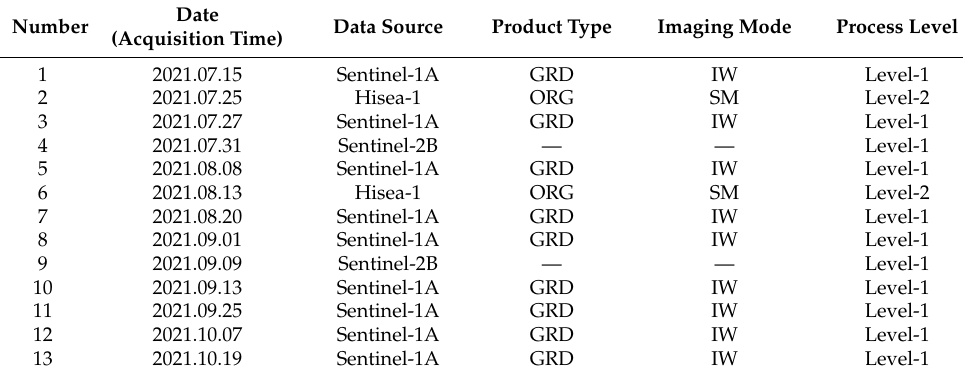
Table 1. Information on the remote sensing data used in this